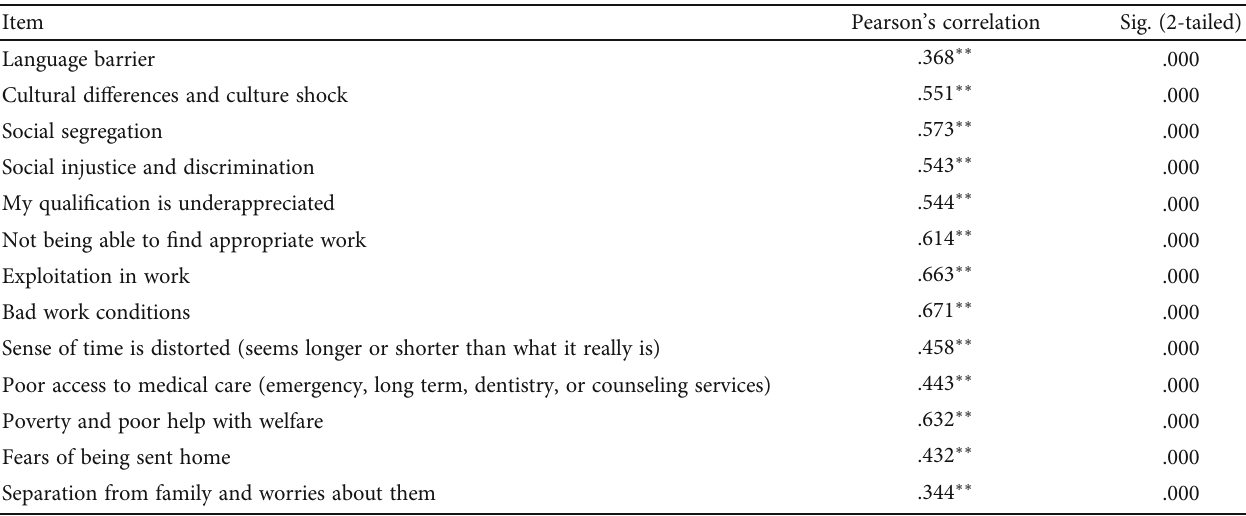
Figure 2: Numbers and percentages of participants as arranged by subgroups. Table 2: Convergent construct validity of the items of the